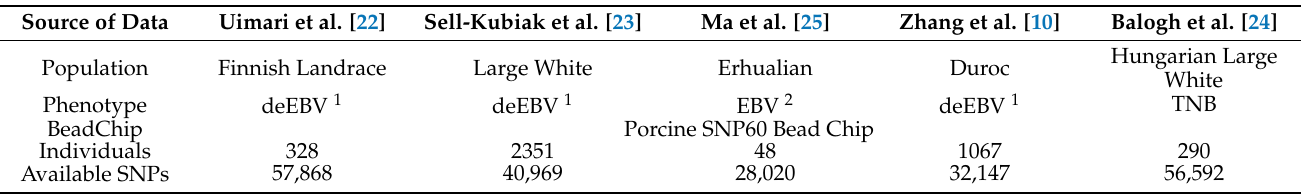
Table 1. Overview of phenotypic and genomic data available for meta-analysis of GWAS results for total number born (TNB) collected in dataset B